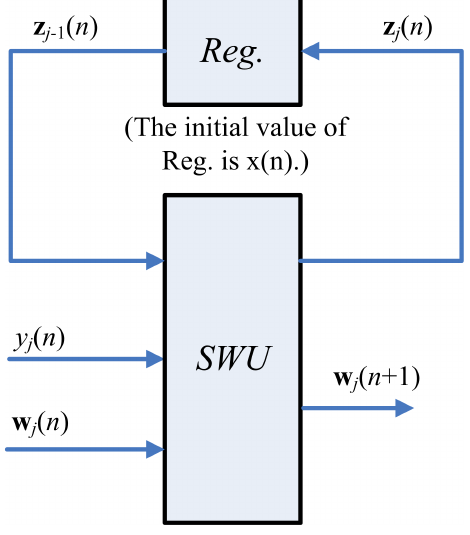
Figure 2. The hardware implementation of Equations (14) and (16).